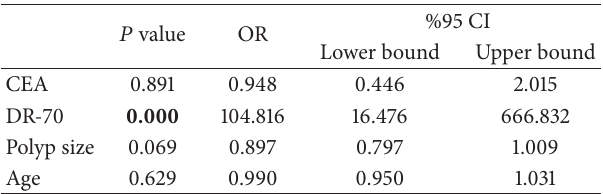
Table 2: Correlation between CEA, DR-70, and clinical parameters. CEA (ng/mL)